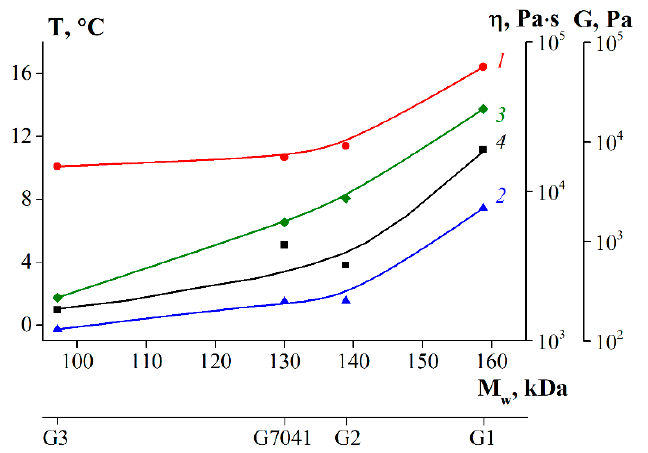
Figure 11. Dependencies of fish gelatin properties on molecular weight, where 1—T m , 2—T g , 3— η ,